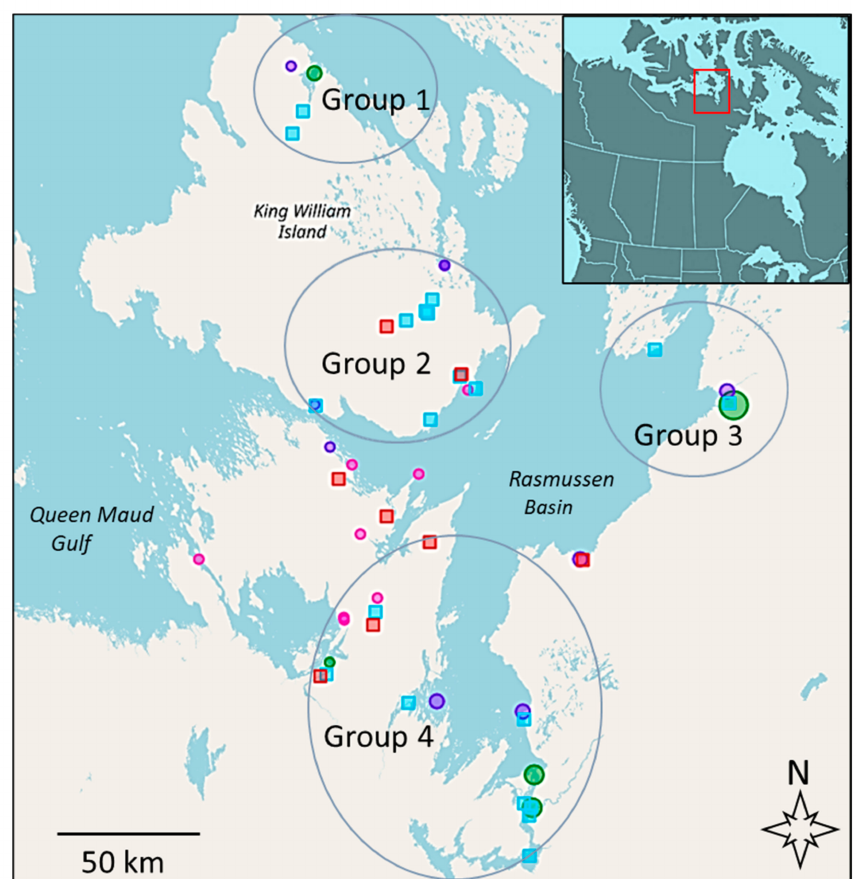
Figure 1. Map of the lower Northwest Passage region of the Kitikmeot in Nunavut (insert shows its location relative to a portion of North America), showing sites where fish were sampled and places of community concern for fish contaminants in subsistence food. Fish sampling sites are indicated by turquoise squares, clustered into four separate groups for statistical analysis: Group 1 for sites on the north of King William Island (sites 1 and 26), Group 2 for sites on the rest of the island close to the hamlet of Gjoa Haven at the southeast side of King William Island (sites 2, 3, 10, 17, and 21–24), Group 3 for fishing sites to the east of Rasmussen Basin (sites 8 and 14), and Group 4 for those on the southern mainland (sites 6, 7, 13, 18–20, 28–29). Additional non-traditional fishing sites used to enrich the genetic analysis, including site 31 are not shown. The map also shows open commercial fish harvesting sites (green circles, with the size of the symbol representing the permitted harvest), test fishing sites (pink or purple dots for currently open or closed test sites, respectively), and additional sites that the community would like to test for contaminants in the future (orange squares). Maps such as these are available as on-line atlases to the community and the public (https: // tsfn.gcrc.carleton.ca / index.html?module = module.tsfnatlas.quotas), with some